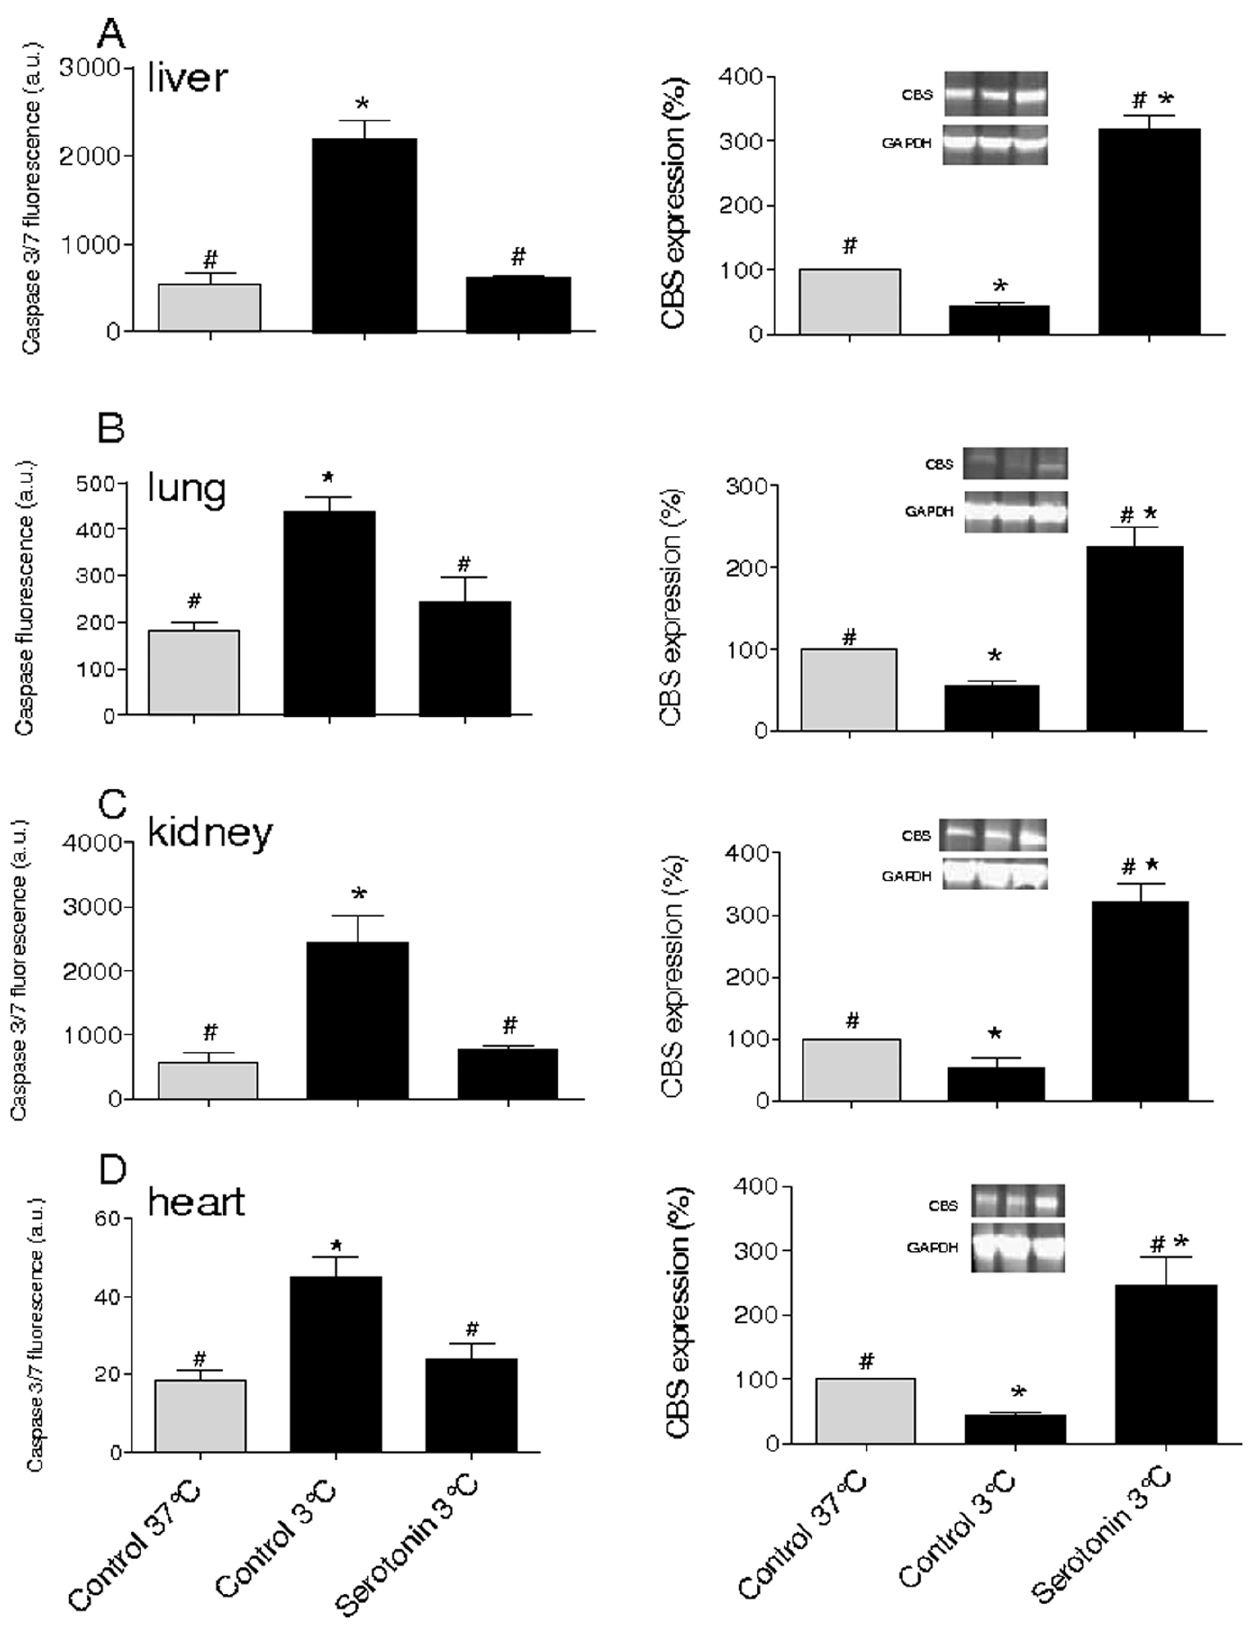
Figure 4. Serotonin increases cystathionine- b -synthase (CBS) expression and minimizes apoptosis in rat tissue during cold storage. Rat tissues were cut in slices in isotonic PBS and subjected to 24 h storage at 3 u C followed by processing for analysis by fixation or snap-freezing. ( A to D ) cold storage of indicated tissues activates caspase 3/7 (left panels) and downregulates CBS (right panels), which is reversed by serotonin